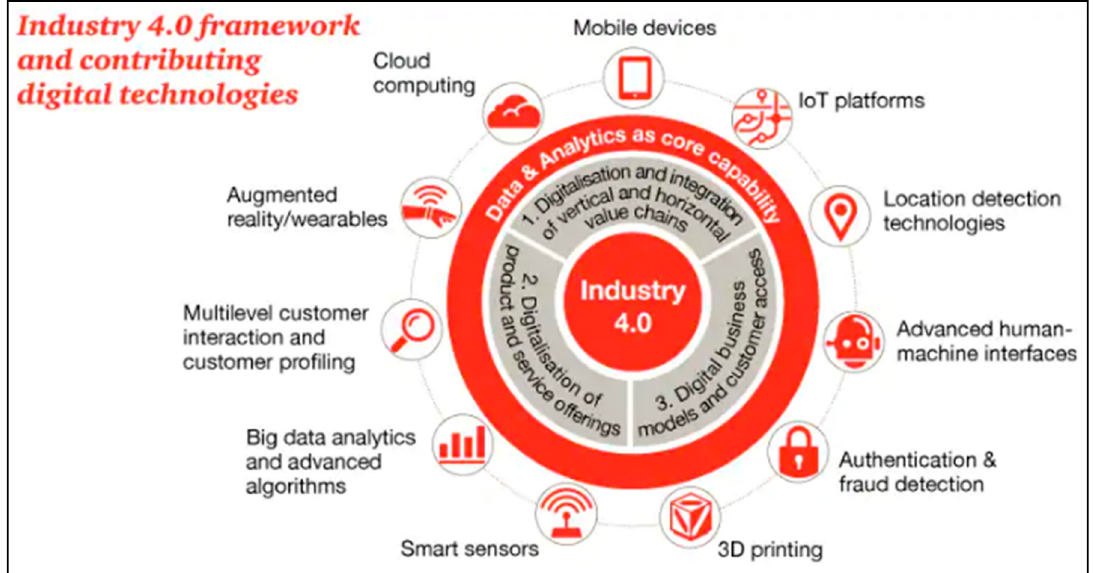
Figure 2. Industry 4.0 technology features and contributions towards digitalization. Source: Industry Figure2. Industry4.0technologyfeaturesandcontributionstowardsdigitalization. Source: 4.0: Building the digital enterprise, 2016 global industry 4.0 survey, PwC engineering, & construction 2016.